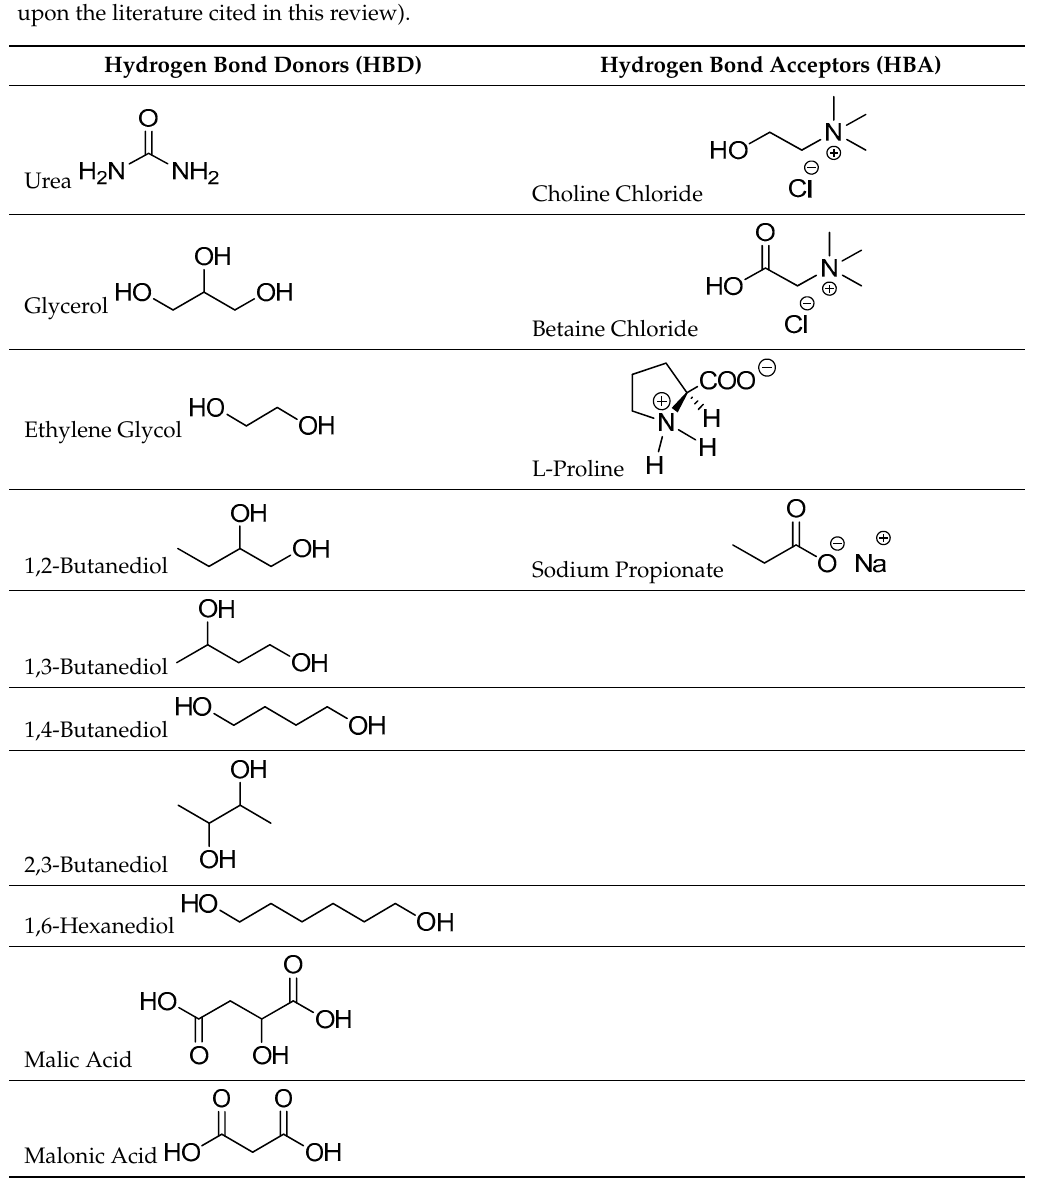
Table 1. Common ingredients for deep eutectic solvents (DES) used in flavonoid extraction (based upon the literature cited in this review).